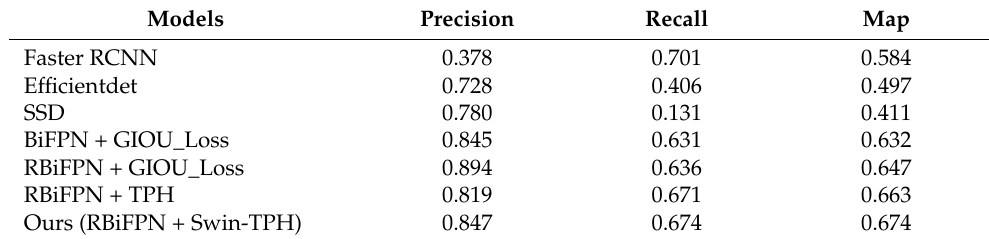
Table 3. Comparison of different smoke.